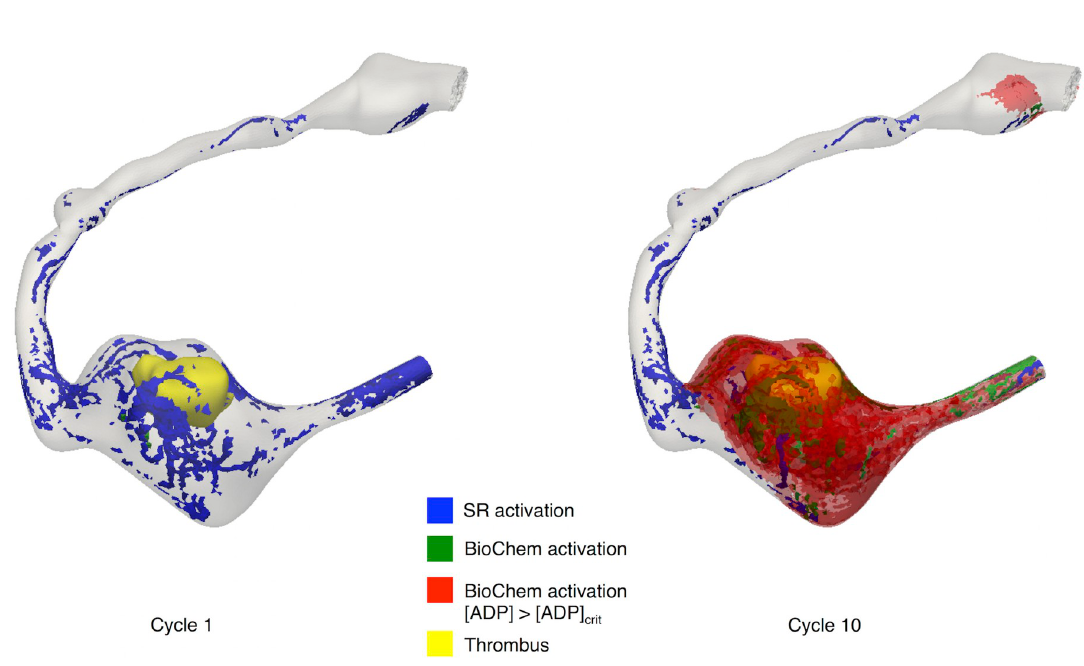
Fig 8. Qualitative comparison of platelet activation due to mechanical and biochemical contributions as a function of time. Thrombus 3D segmentation in yellow.